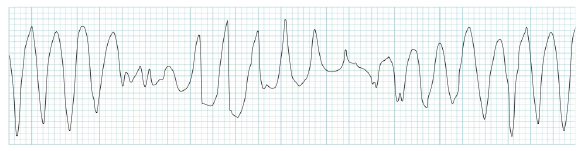
Figure 1: Torsades de